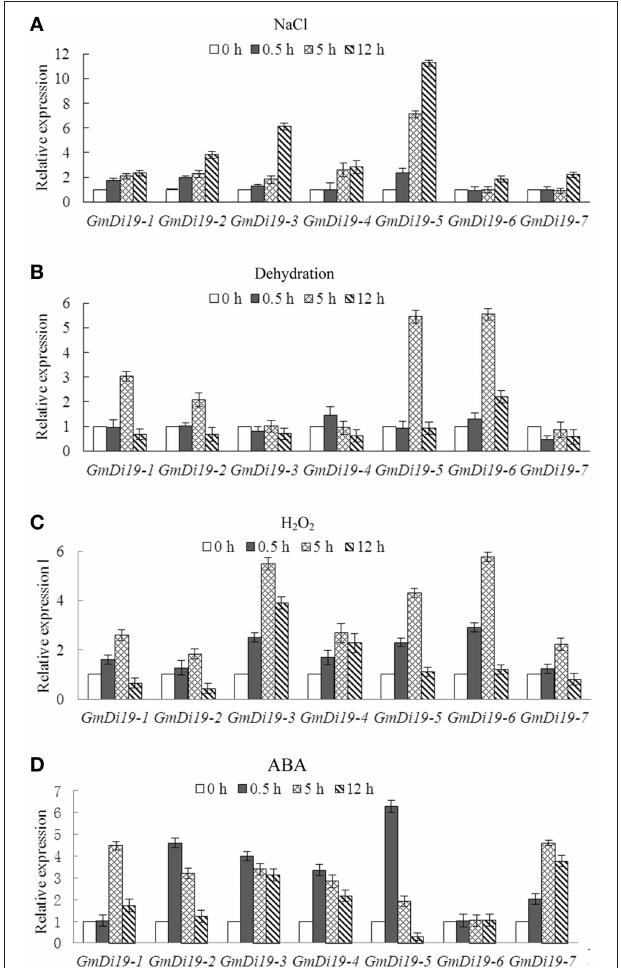
FIGURE 4 | Relative expression profiles of the Di19 genes in the 2-week-old soybean seedlings subjected to NaCl (A), dehydration (B), H 2 O 2 (C), and ABA (D) stress treatments. The transcript levels of each Di19 in the stress-treated plants were plotted as the relative expression (fold) of the non-stressed control plants for 0.5, 5, and 12h. The transcript level of Actin was used as a reference. Mean values and standard errors (bar) were shown from three independent